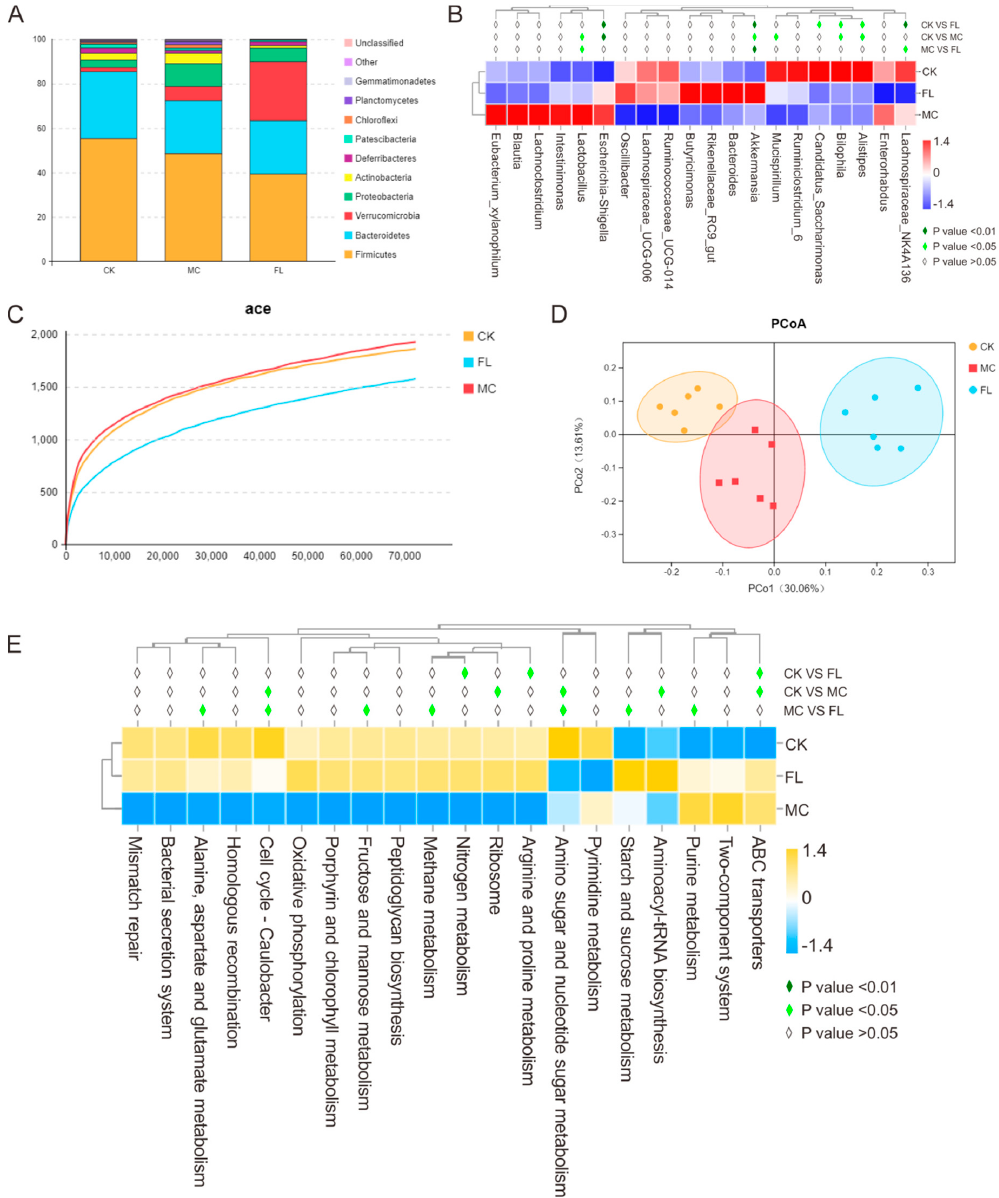
Figure 3. Relative abundance, diversity, and function prediction of intestinal microbiome in different groups of mice: ( A ) Phylum level; ( B ) genus level; ( C ) dilution curve; ( D ) PCoA analysis based on operation taxonomic unit (OTU) results; ( E ) Tax4Fun analysis based on SILVA database.